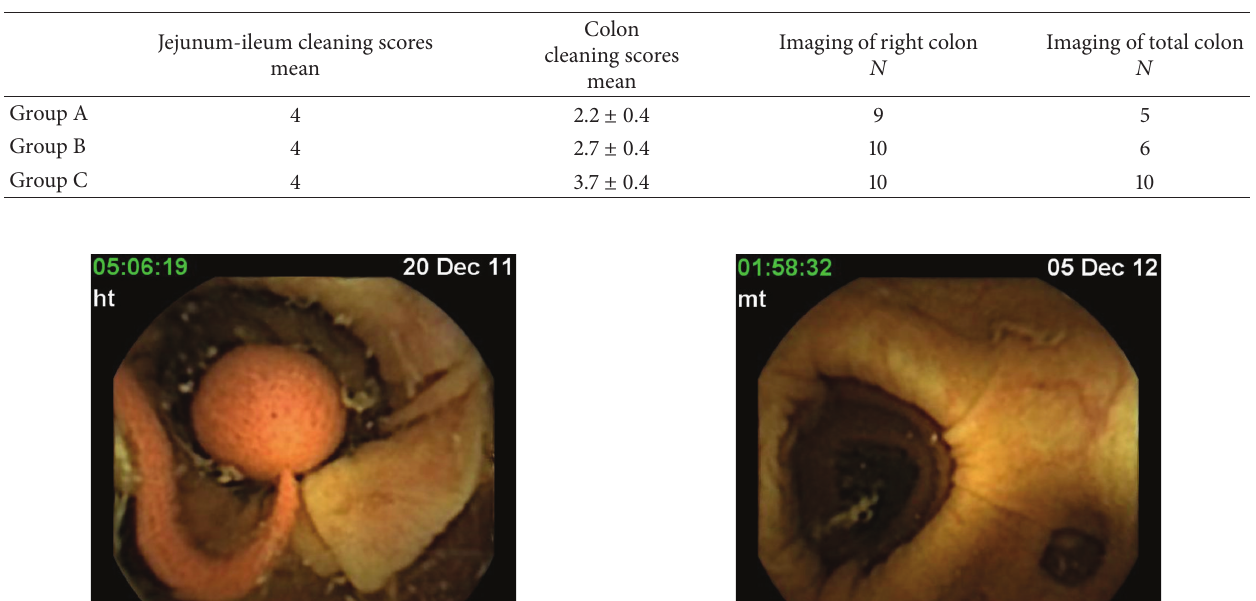
Table 1: Cleaning scores and imaged segments of colon by CCE.